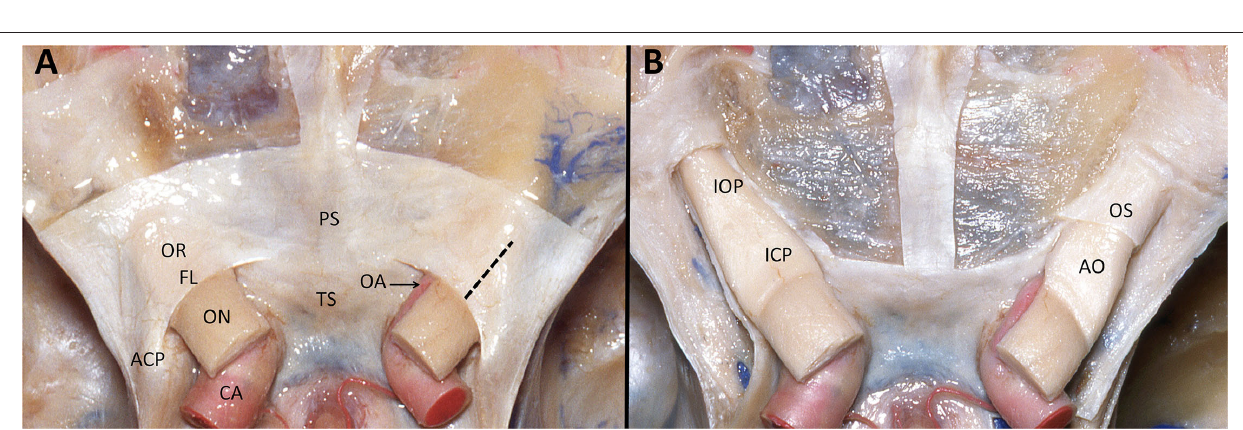
FIGURE 5 | (C) Dissection and removal of the dura is performed. Drilling of the roof, lateral and medial wall of the optic canal were performed. (D) Incision of the falciform ligament with an angular blade N ◦ 11 was performed. (E) The optic nerve became gently retractable away from the carotid artery where the aneurysmal neck is easily exposed for its clipping. The arrow marks the level where the falciform ligament was. (F) Final image of the carotid-ophthalmic clipped aneurysm. Decompression of the optic nerve is demonstrated. OR, Optic roof; ON, Optic nerve; CA, Carotid artery; FL, Falciform ligament; Star, Protrusion of the optic nerve due to the aneurysm; Arrow, location where the falciform ligament was prior to the excision; An, Aneurysm.